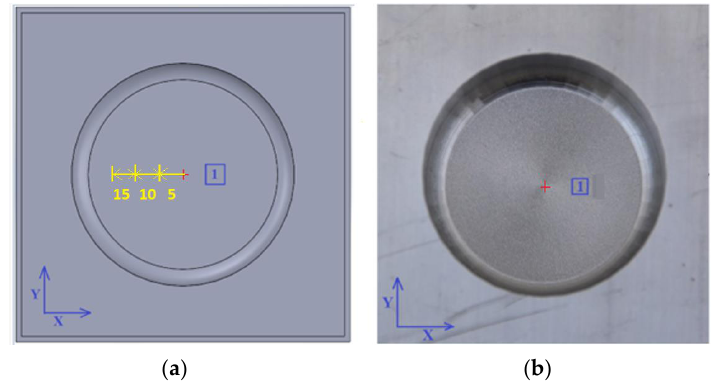
Figure 10. Surface texture observation area ( a ) CAD model ( b ) machined part.